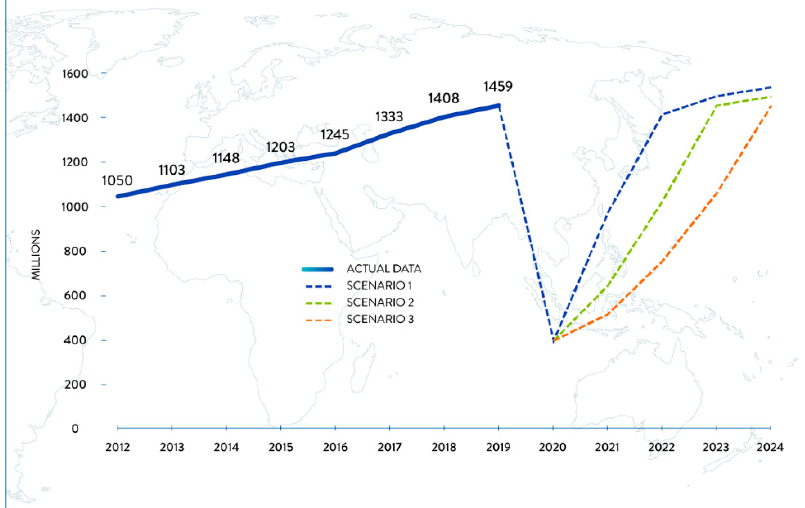
Figure 1. Forecasts of international tourist arrivals in the world after the COVID-19 pandemic. Source: [30] (p. 13).